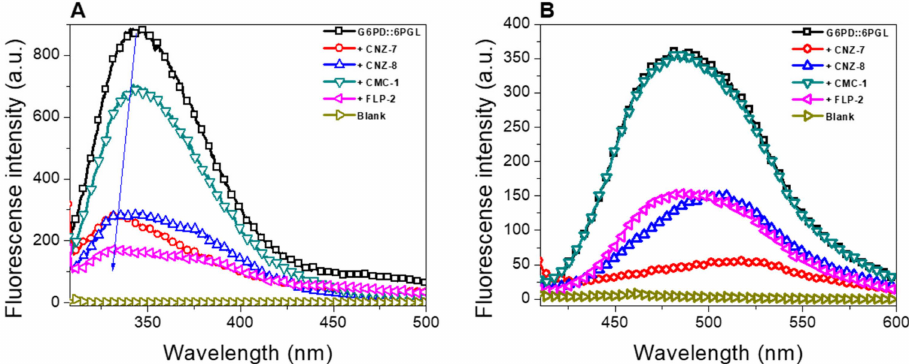
Figure 6. Fluorescence emission spectra of G6PD::6PGL enzyme. ( A ) Intrinsic fluorescence spectra of the G6PD::6PGL enzyme, and ( B ) extrinsic fluorescence spectra ANS assays, free or with CNZ-7, CNZ-8, CMC-1, and FLP-2 chemical compounds. The selected compounds at the IC 50 concentration were incubated with 0.1 mg/mL of G6PD::6PGL protein for 2 h at 37 ◦ C before measurement. The data are the mean of at least four independent